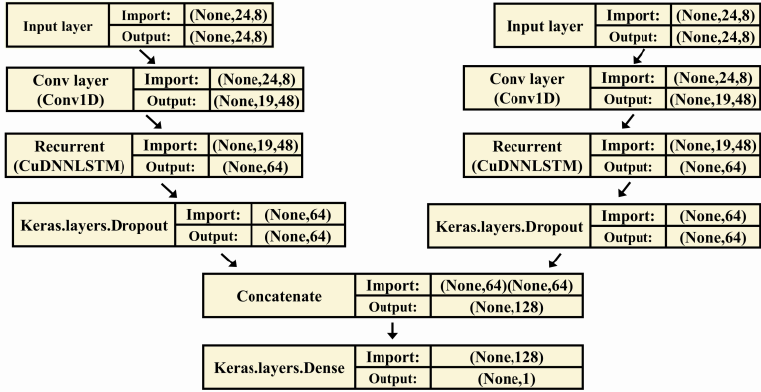
Figure 6. LSTNet network architecture.